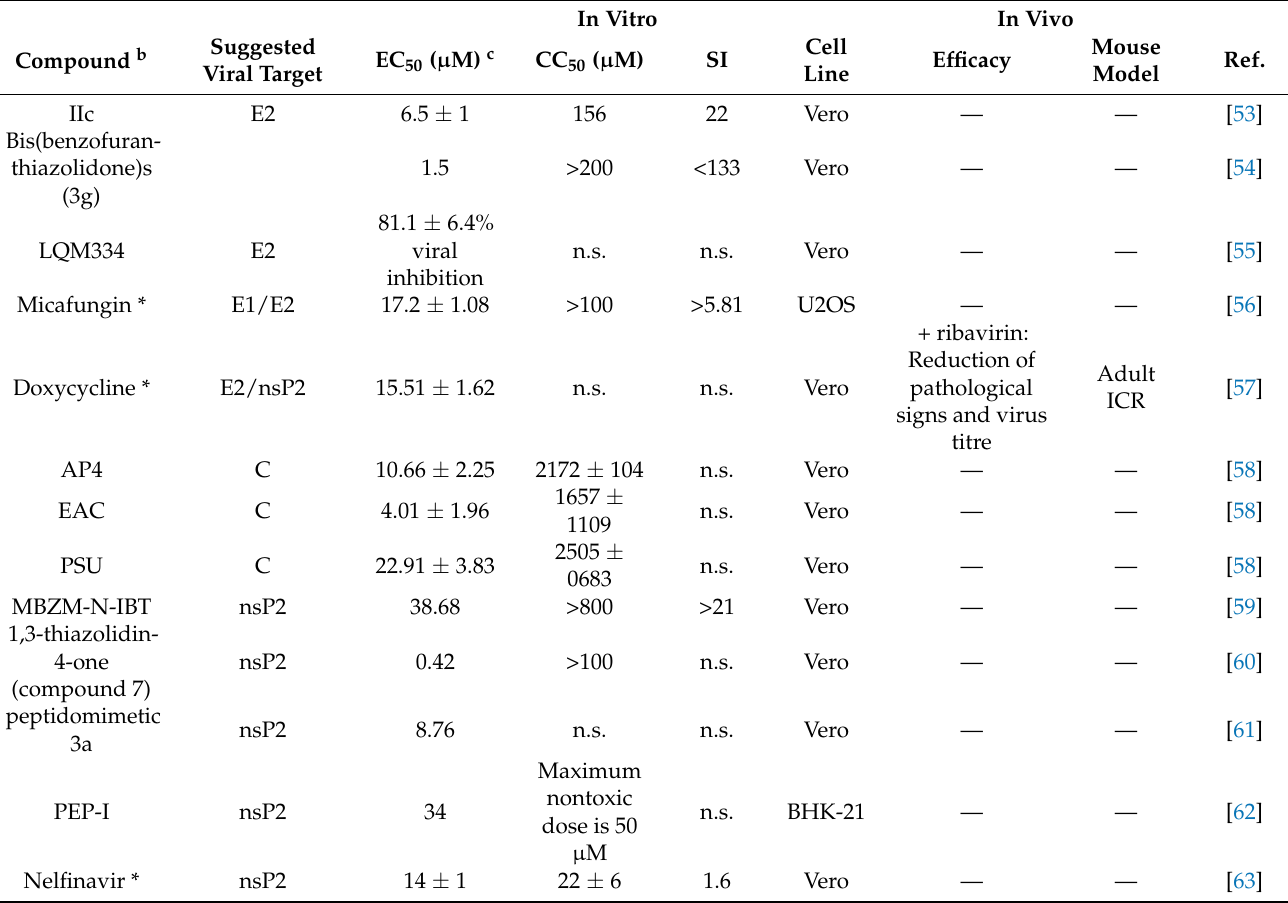
Table 2. Compounds with suggested viral target but without a clear mode of action a